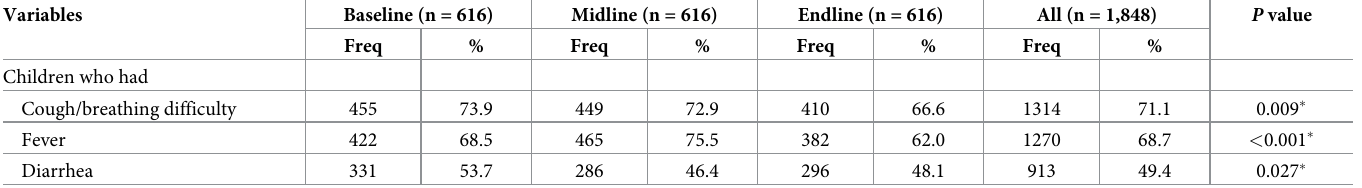
Diarrhea 331 Statistically significant difference at p -value of 0.05.